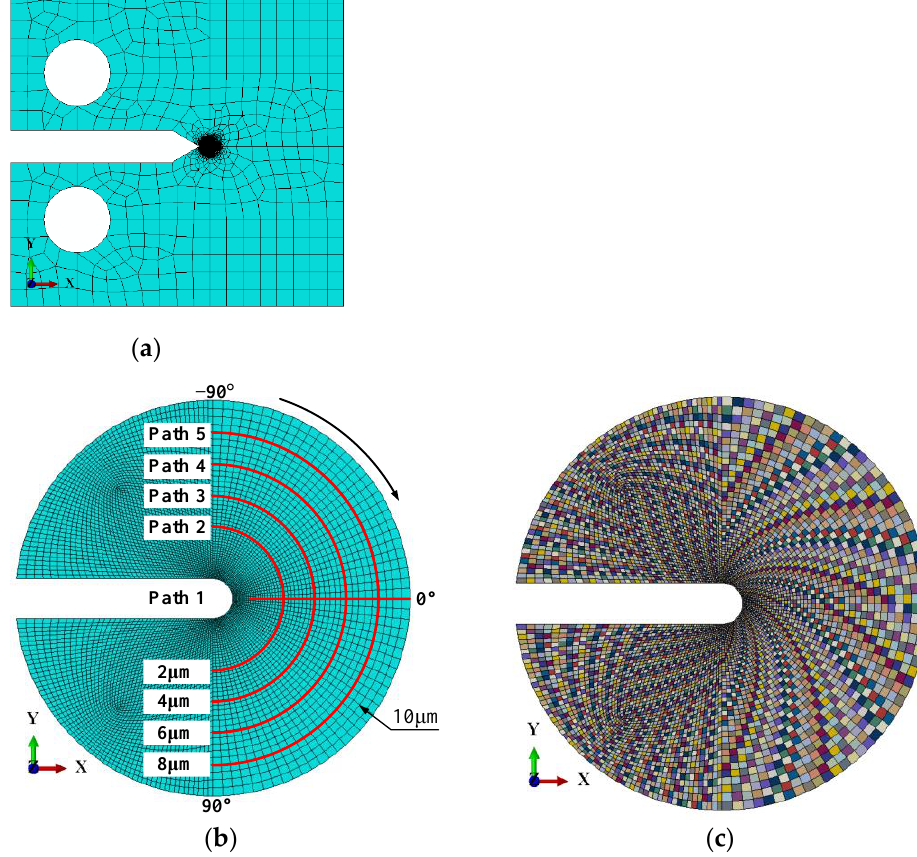
Figure 6. Finite element model of the CT specimen. ( a ) Global model, ( b ) sub-model and observation path. ( c ) Details around the crack tip of the heterogeneous material.